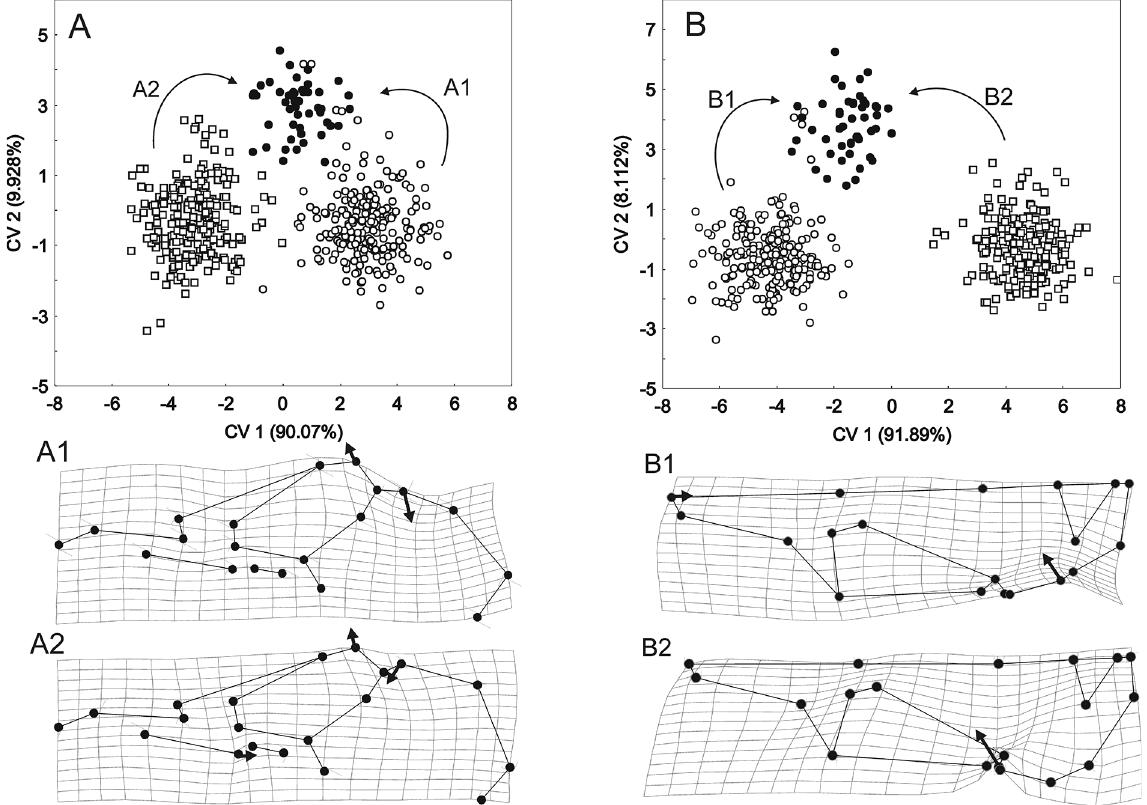
Fig. 4. Scatter plot of the CVA results of the (A) ventral and (B) dorsal shape data of Meriones crassus Sundevall, 1842 (two groups) and M. libycus Lichtenstein, 1823. Legends: ○ = M. crassus (other than Western Zagros), ● = M. crassus of Western Zagros, □ = M. libycus . The grids below show deformation along the arrows, when moving from the M. crassus group mean shape to the Western Zagros group mean shape (A1 and B1), and from the M. libycus mean shape to the mean shape of the Western Zagros (A2 and B2) (shape differences magnified three times for better visualization). For the numbering of landmarks, see Fig.